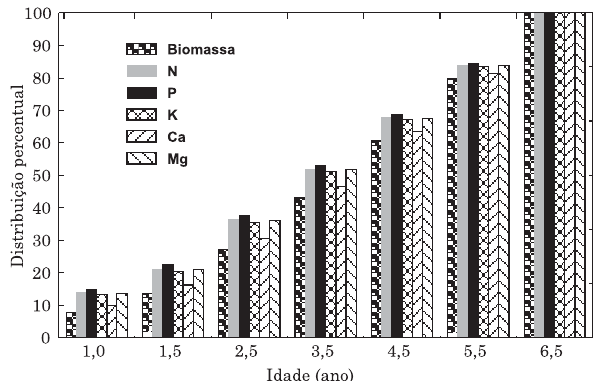
Figura 1. Distribuição relativa de biomassa e de nutrientes na parte aérea de eucalipto no Brasil, considerando a idade, assumindo 6,5 anos como idade de